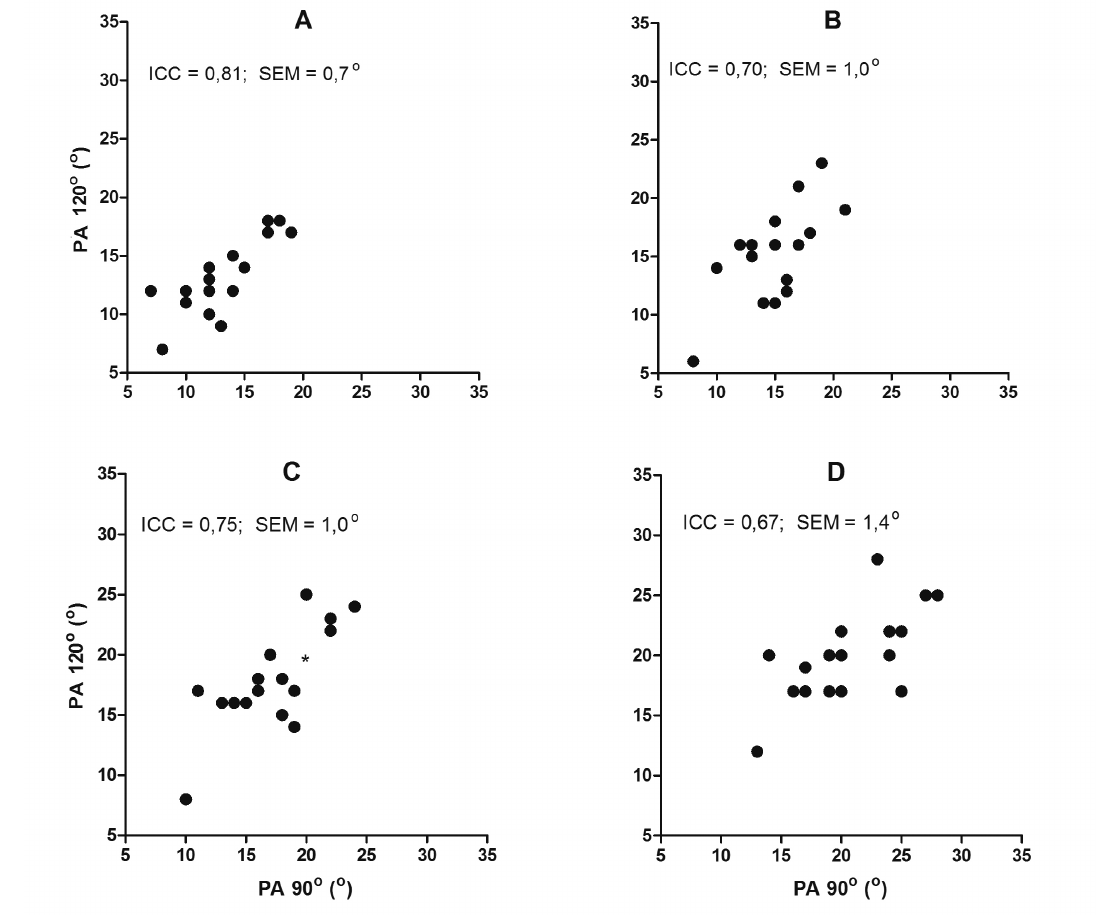
Figure 3 - Scatter plots of the measured PA with the knee at 90º and 120º at the intensities of contraction 25 % (A), 50 % (B), 75 % (C) and 100 % (D), together with the intraclass correlation coefficients (ICC) and the standard error of measure (SEM) determined from each pair of